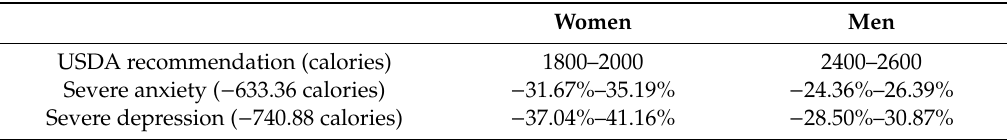
Table 7. Comparison of USDA a recommendation with the potential e ff ects of severe anxiety and depression on caloric